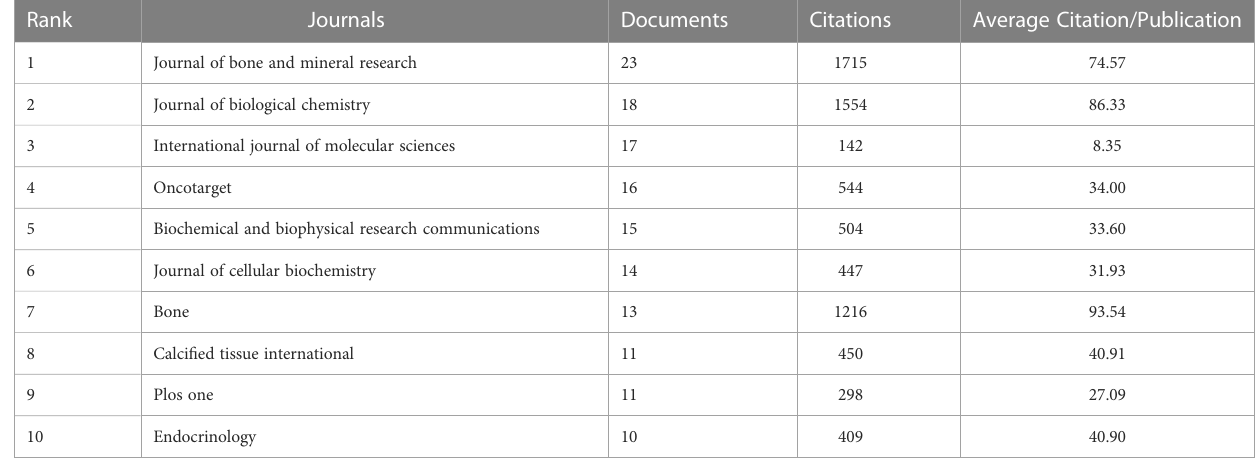
TABLE 2 Top 10 journals published in the fi eld of osteosarcoma metabolism.